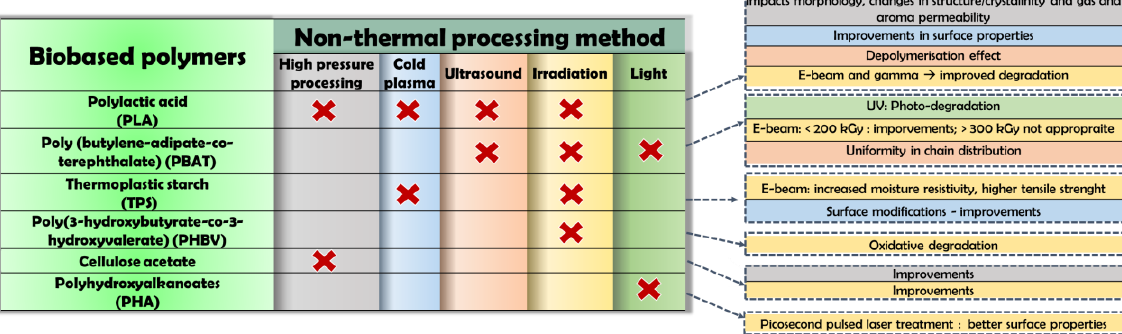
Figure 1. Principle impact of non-thermal food processing on various biobased polymers.